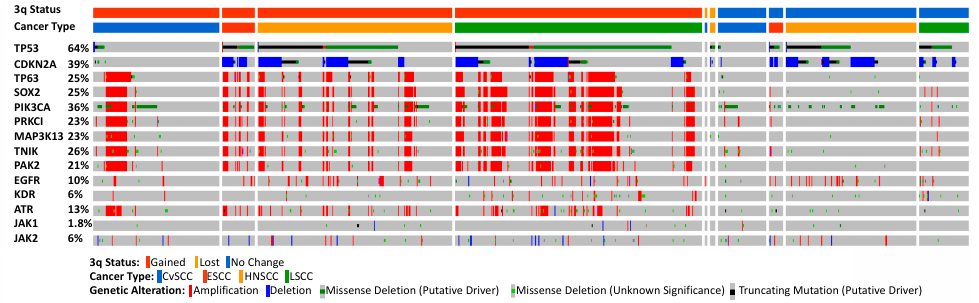
Figure 4. Alteration and mutation frequency of multiple genes within cervix (CvSCC), esophagus (ESCC), lung (LSCC), and head and neck (HNSCC) TCGA data sets using cBioPortal. Genes include the most altered gene, TP53 ; the HPV biomarker, CDKN2A ; the 3q amplicon genes; and current genes being targeted in clinical trials. A total of 1317 patients were analyzed for gene alteration/mutation, of which 957 were analyzed for 3q status.